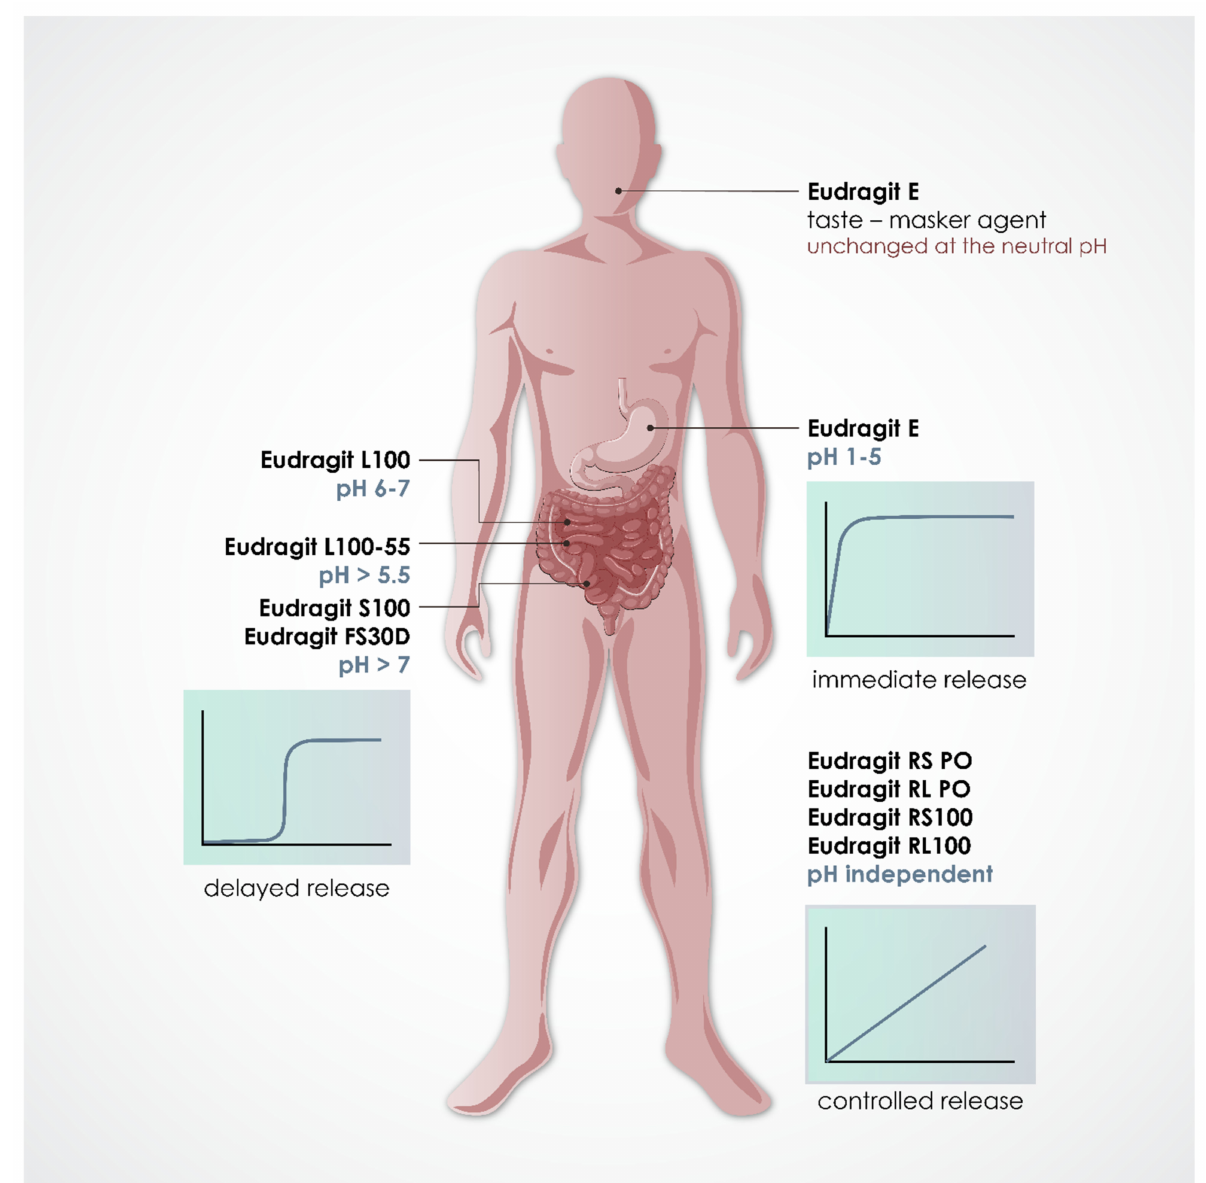
Figure 4. Predictable drug release site from dosage forms produced with Eudragit polymers, according to their physico- chemical